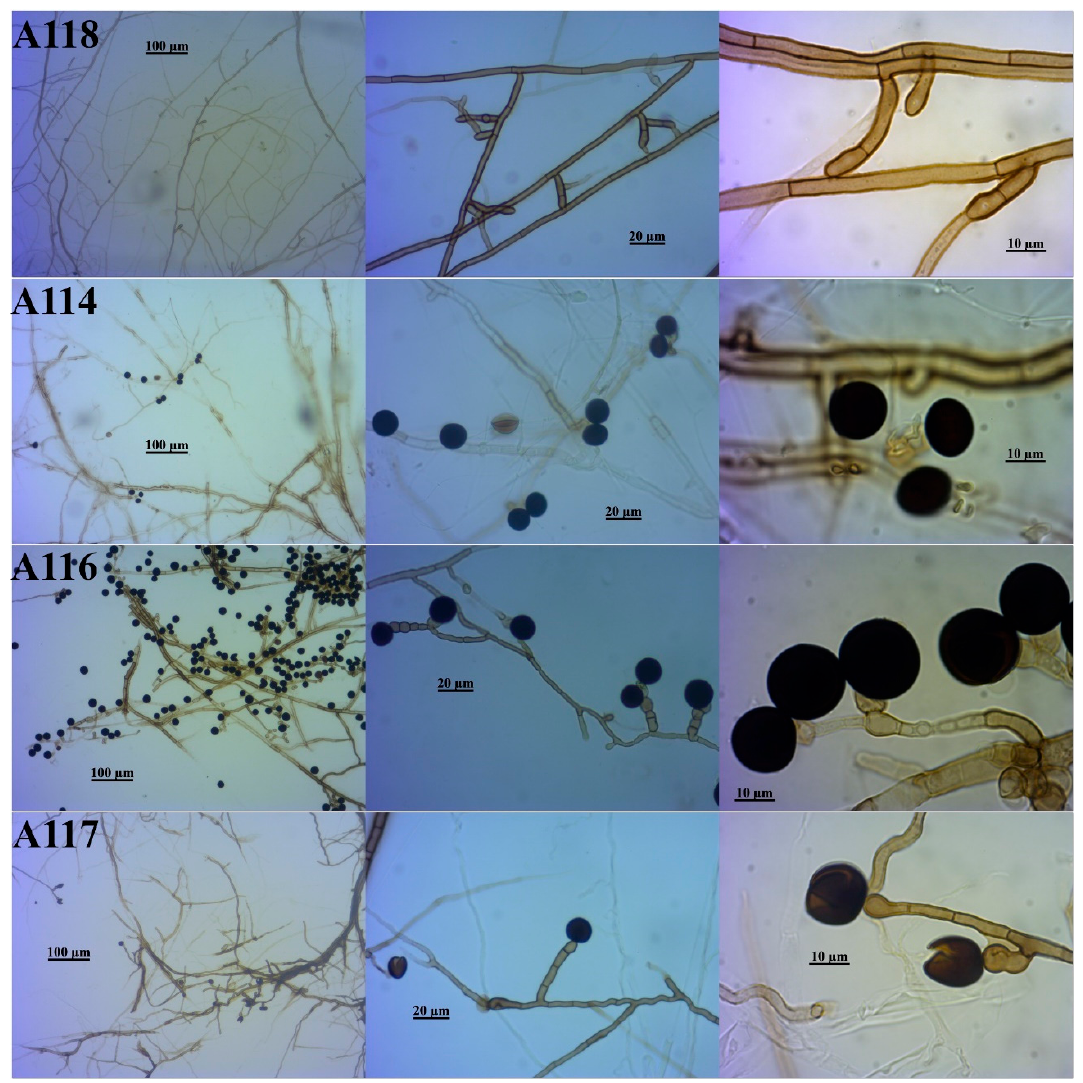
Figure 5. Micromorphology of hyphae and other fungal structures of DSE fungi (A114, A116–A118) grown in malt extract agar after isolation from sugarcane roots sampled in the Quatá region, São Paulo, Brazil.